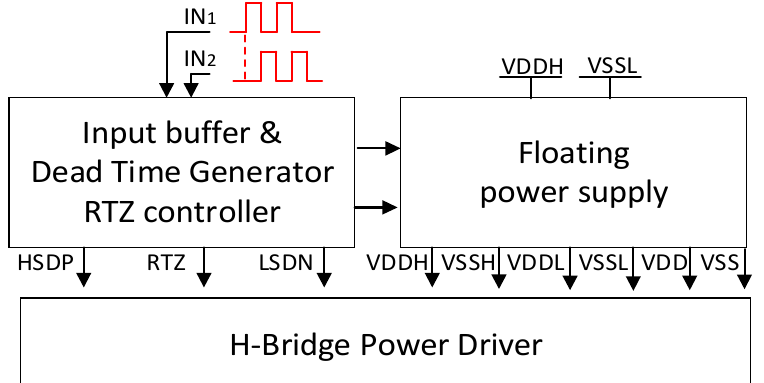
Figure 5. Proposed architecture of the integrated bipolar pulse driver (VDDH is the highest voltage, while VSSL is the lowest voltage supplied to the system, RTZ presents the return-to-zero control signal. HSDP and LSDN present the high-side and low-side control signal, VDD sets 5V and VSS sets -5V, and VSSH and VDDL are set by VDDH and VSSL, respectively, as defined in Equations (9) and